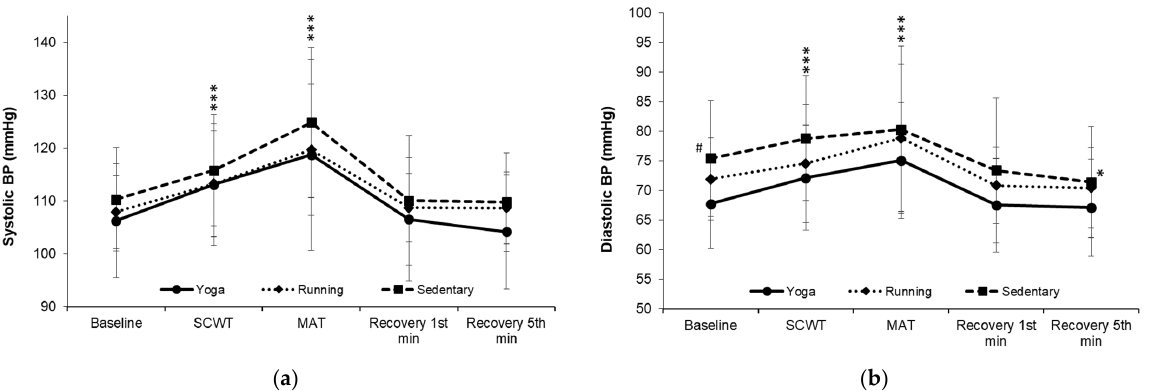
Figure 3. ( a ) Changes in the systolic BP over time. ( b ) Changes in the diastolic BP over time. BP, blood pressure; SCWT, The Stroop color and word test; MAT, The mental arithmetic task. # significantly different from yoga group, p < 0.05. * significant difference between baseline and each phase within a group, p < 0.05.